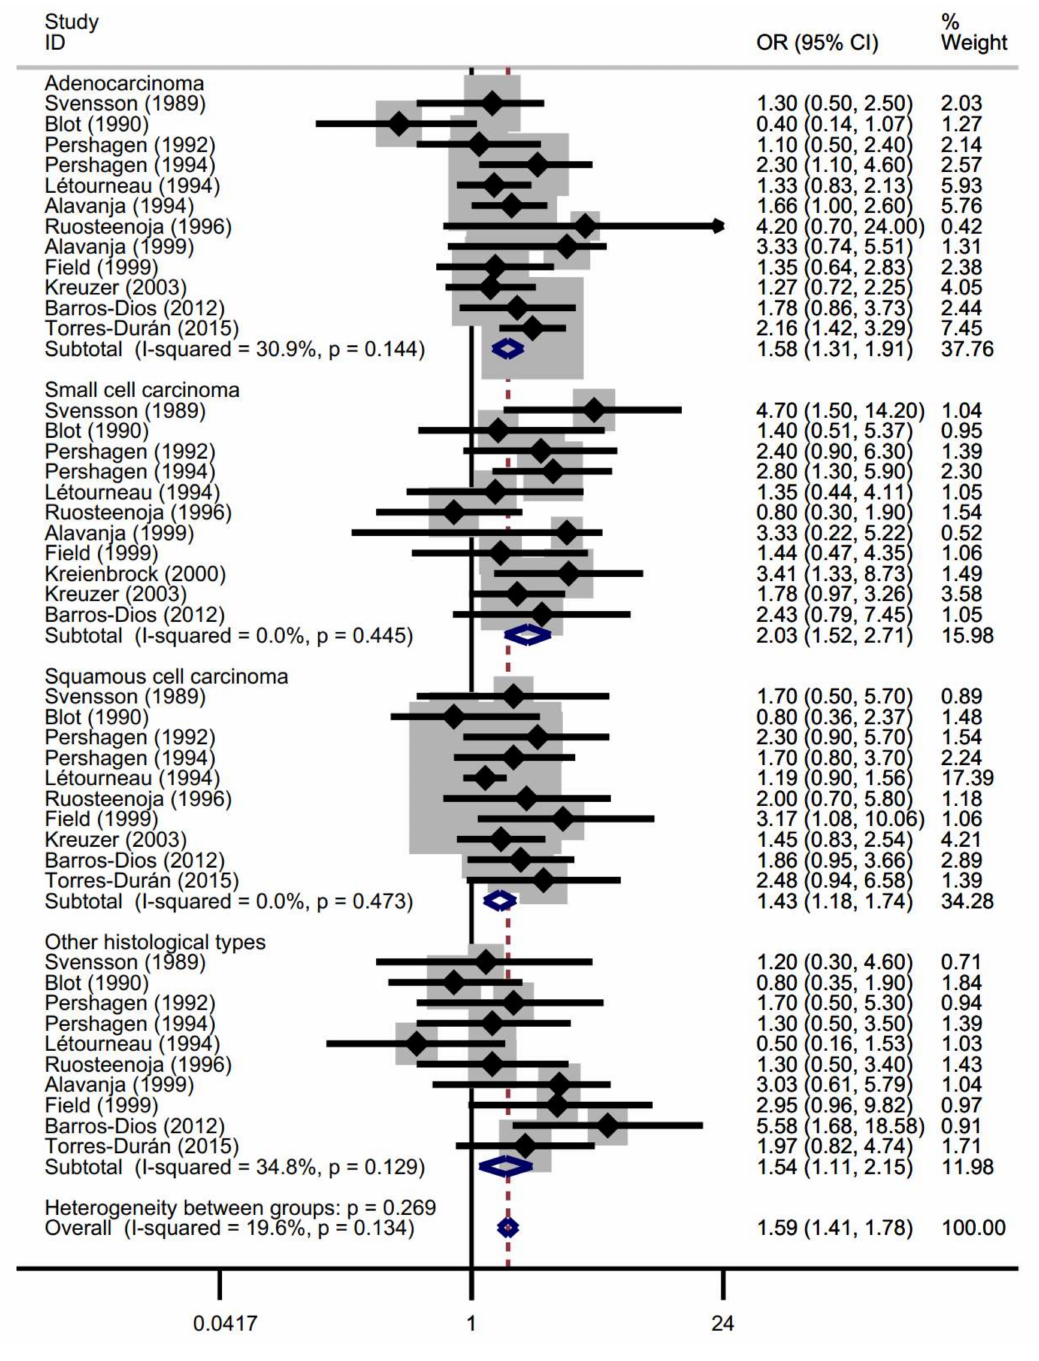
Figure 3. Forest plot of the associations between lung cancer risk and residential radon exposure (highest versus non / lowest) stratified by types of